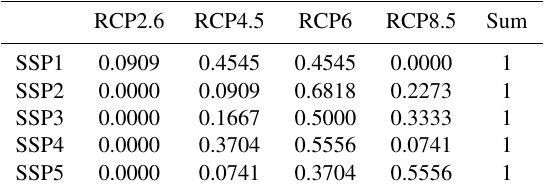
Table 1. Scenario matrix translated into quantitative probabilities (see also Engström et al.,